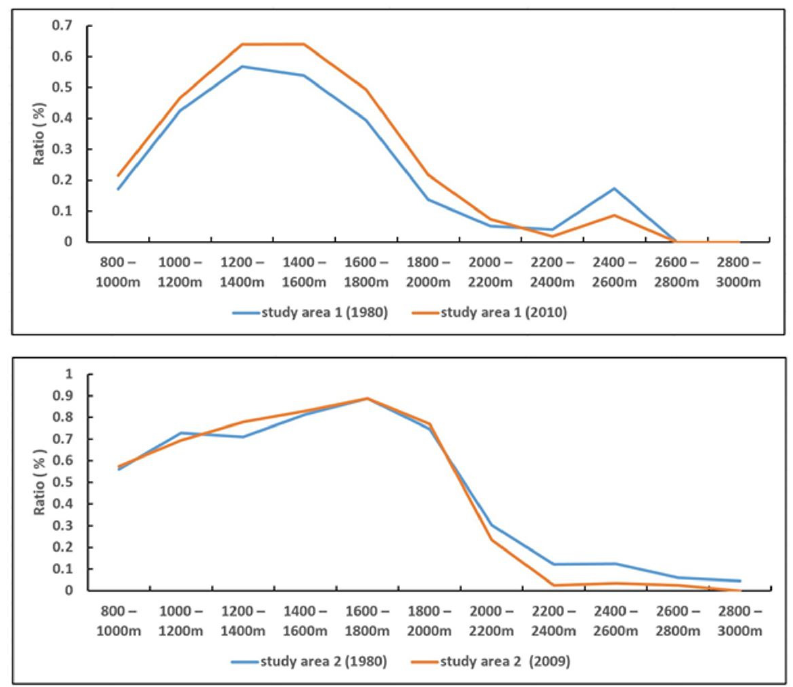
Figure 14. Distribution of the class “dense forest” between images from 1980 (study areas 1 and 2) and from 2009 (study area 2) and 2010 (study area 1) based on normalized elevations. ( Top panel ): study area 1, ( bottom panel ): study area 2.